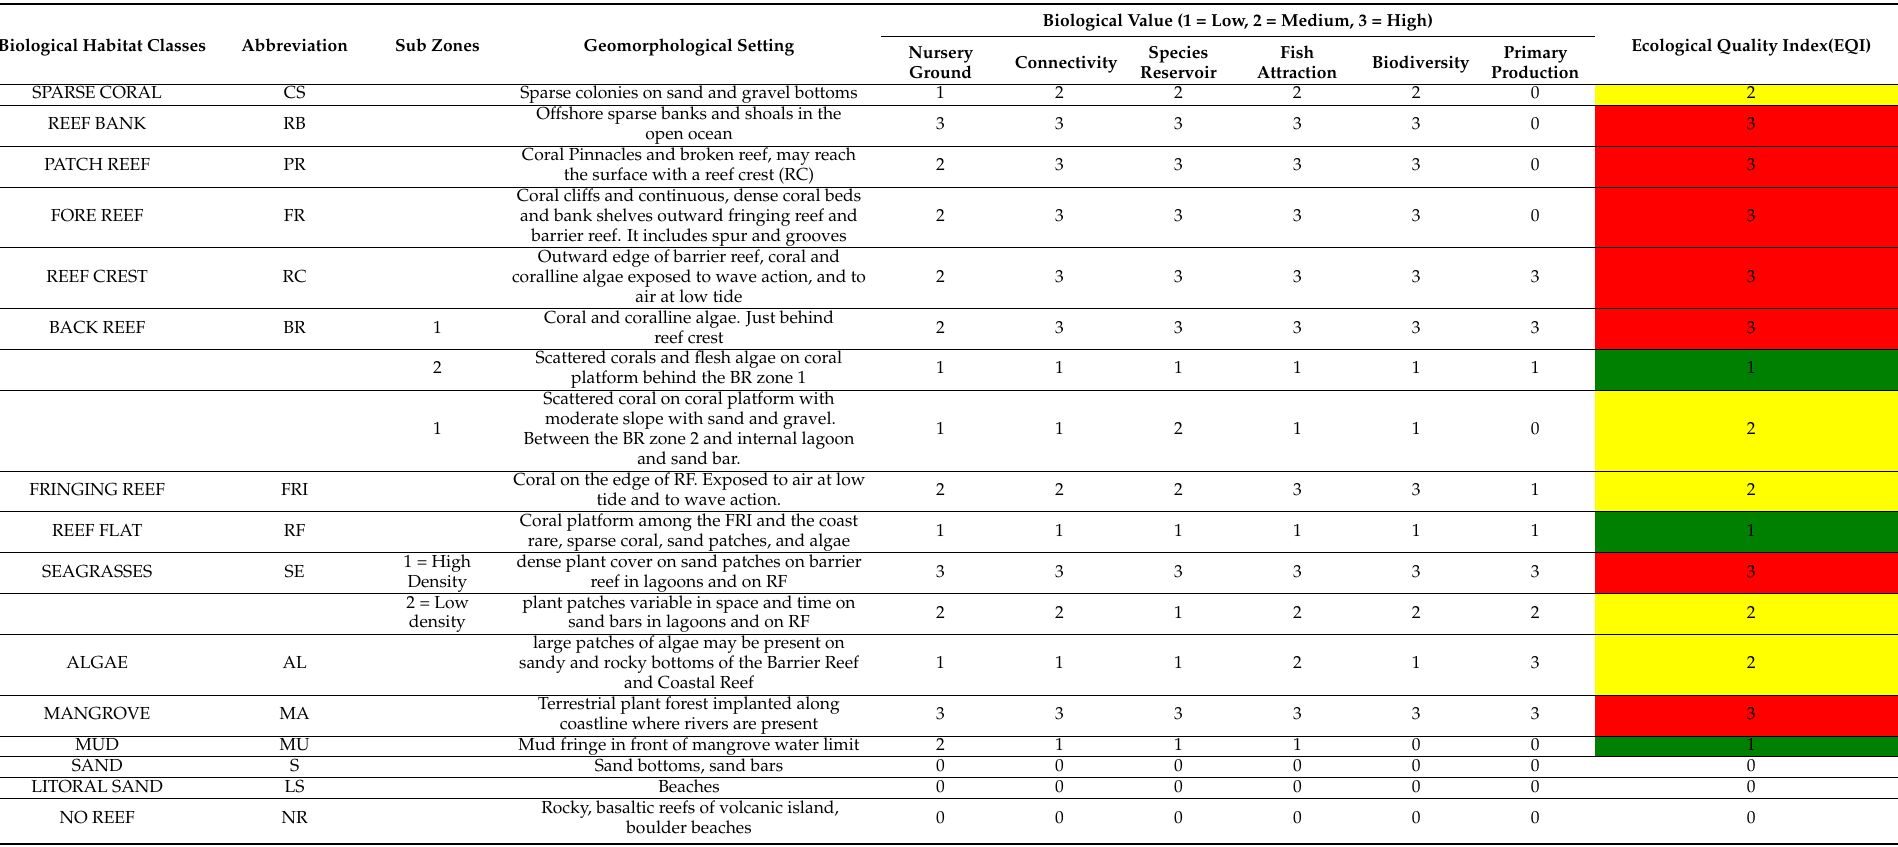
Table 3. Main Classes and subzones used for Tonga habitat mapping. The Ecological Quality Index (EQI) was calculated as the mean of the three-level